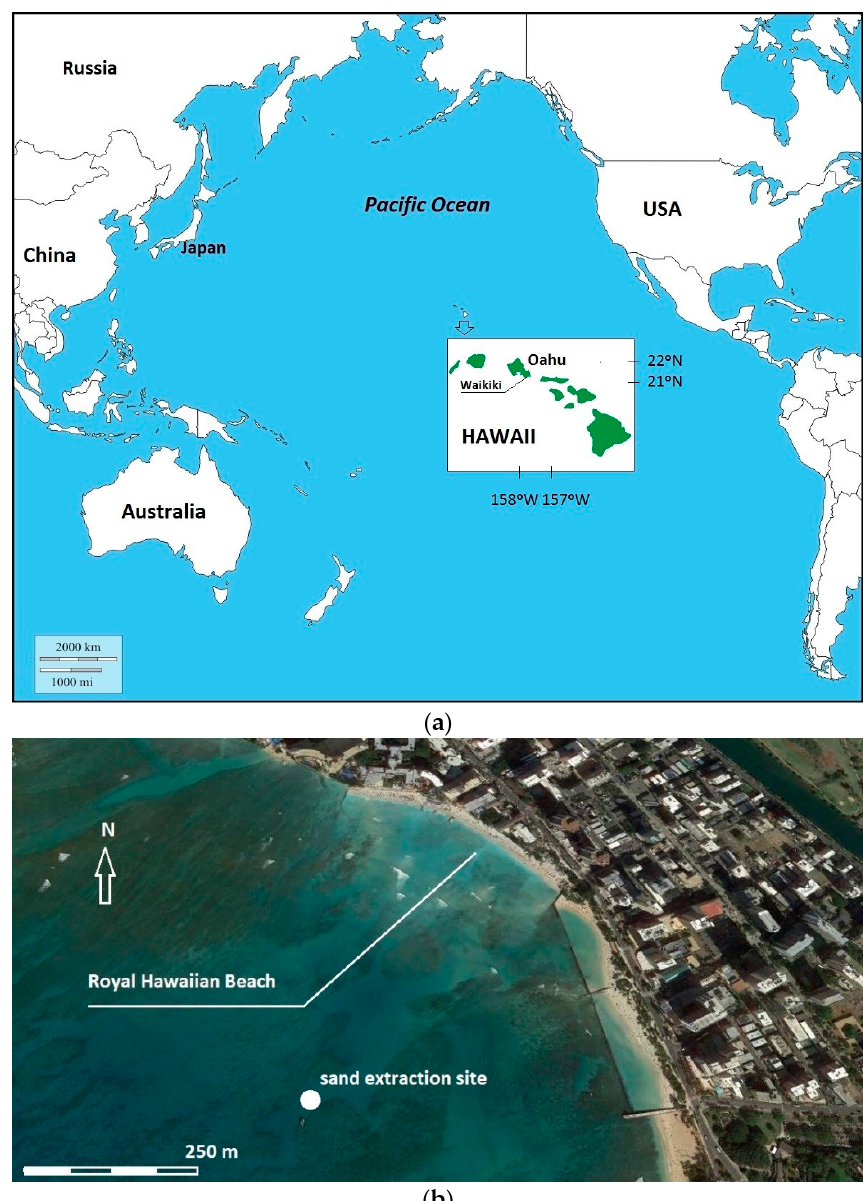
Figure 1. Location of Royal Hawaiian Beach (RHB) in Waikiki, Hawaii, USA ( a ); and an aerial view where the fringing reef can be observed and the sand extraction site is located ( b ) (image source: Google Earth 2018).